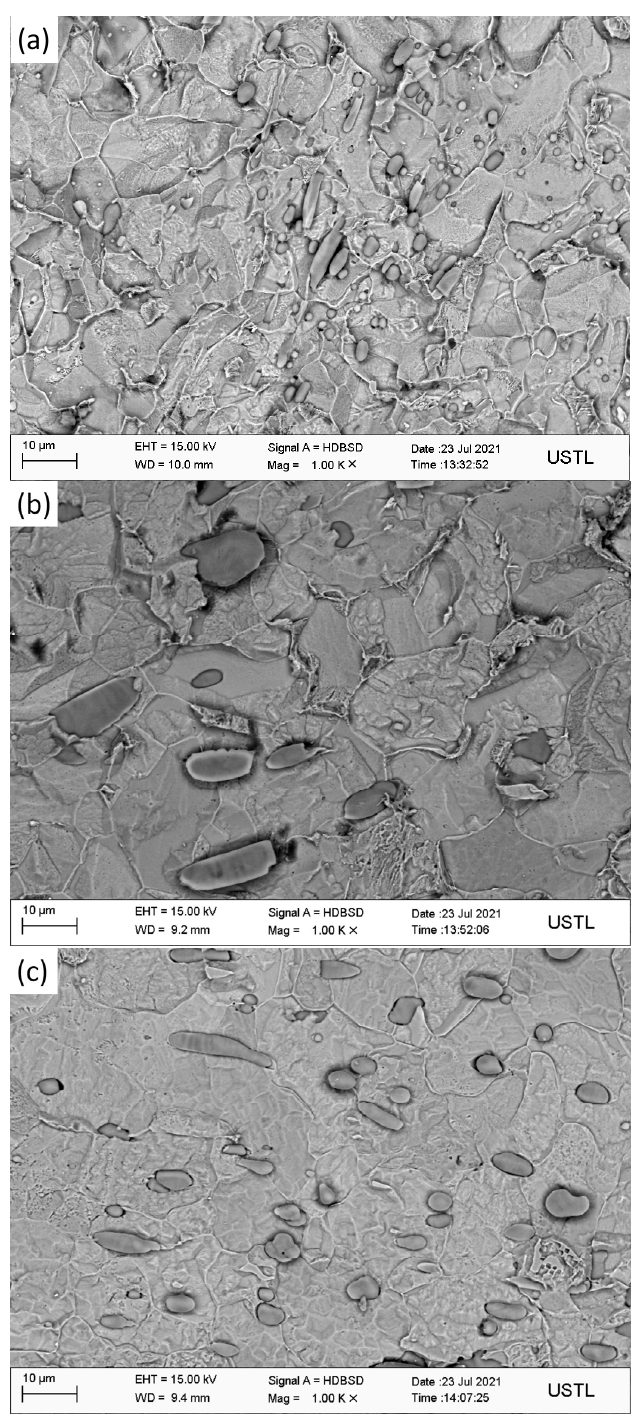
Figure 7. Morphologies observation of inclusions in three groups of steels after corrosion: ( a ) 1#; ( b ) 2#; ( c )